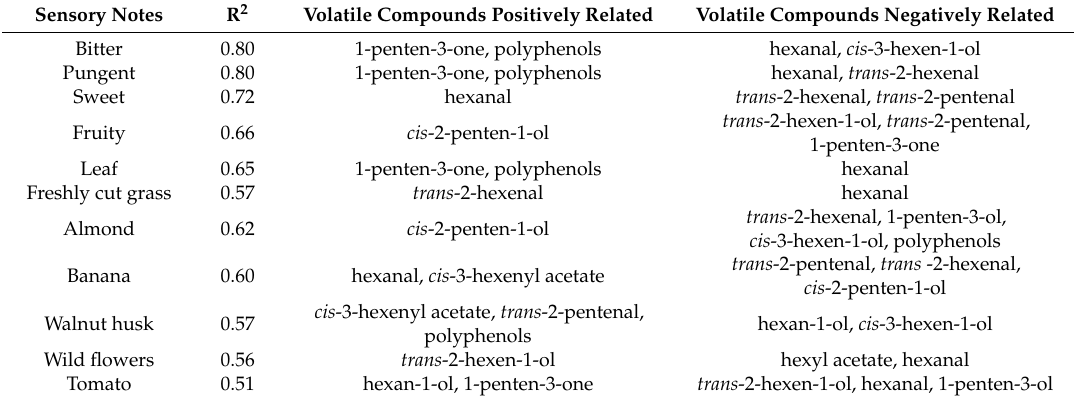
Table 1. Green attributes correlated to volatiles from LOX pathways and to the total amount of phenolic compounds. (Source: Authors; unpublished